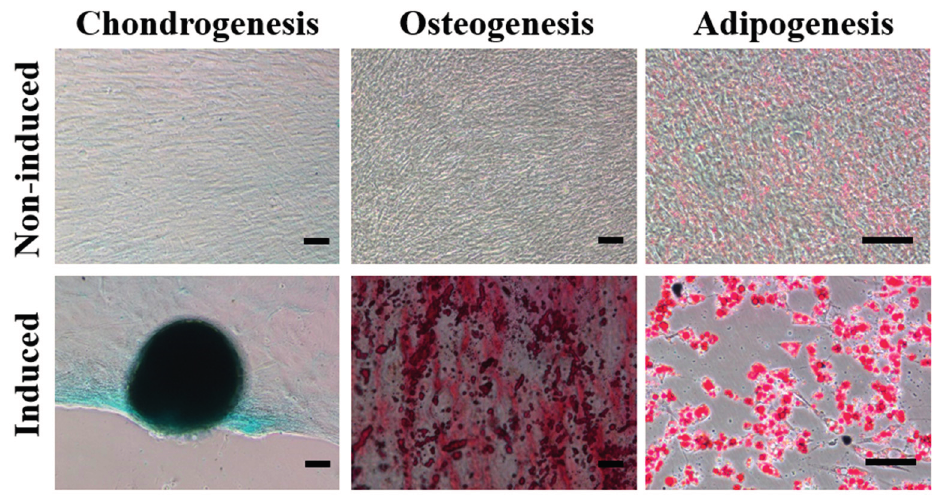
Figure 2. Differentiation of human adipose-derived mesenchymal progenitor cells (haMPCs). Multipotent differentiation of haMPCs showed positive staining toward chondrogenesis (Alcian Blue), osteogenesis (Alizarin Red) and adipogenesis (Oil Red O). Scale bars = 50 μ